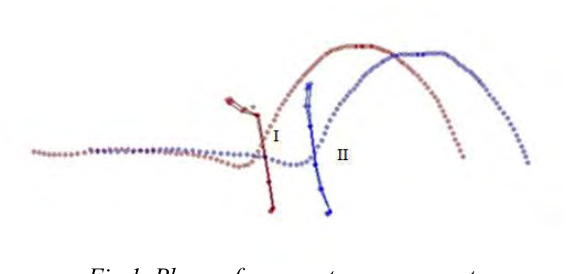
Fig.1. Phase of preparatory